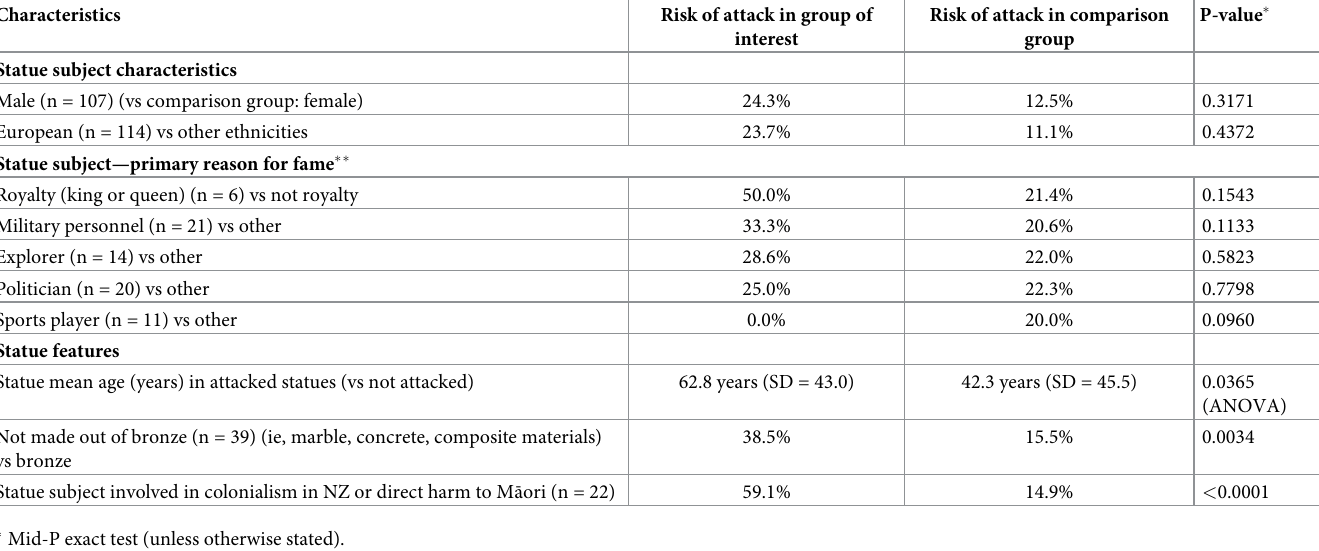
Table 3. Characteristics of attacked (n = 28) and non-attacked (n = 95) statues (for any attacks over the “lifetime” of each statue). Characteristics